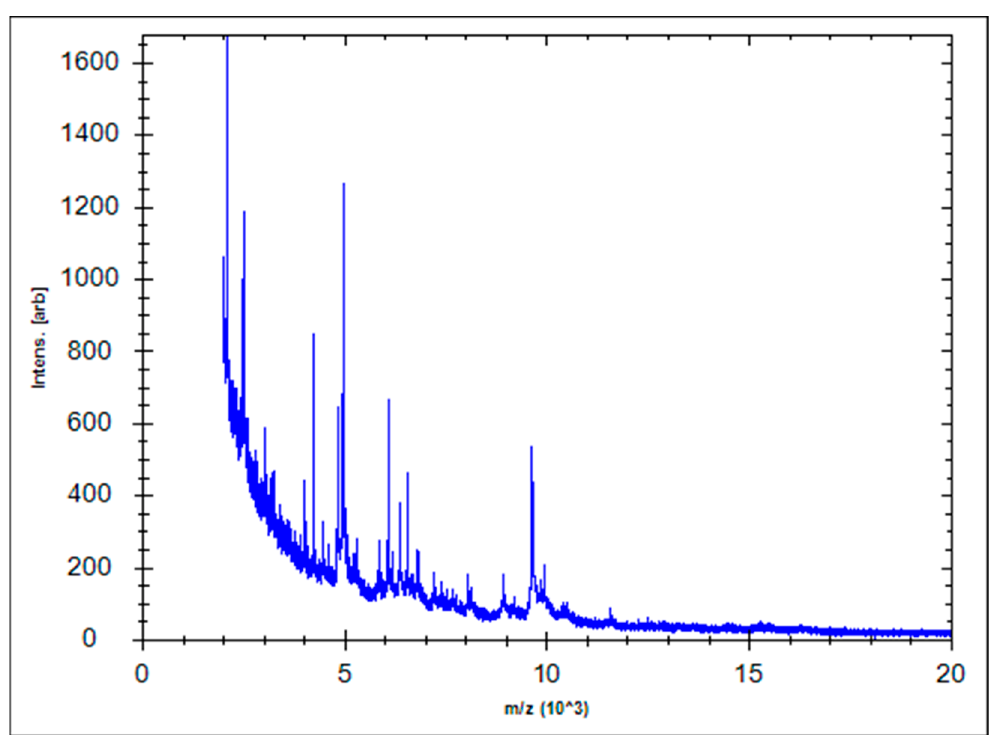
Figure 2. Spectra of S. xylosus generated using MALDI-TOF Bruker Biotyper. The y-axis represents the absolute intensity of the ions and x-axis represents the mass (m/z). The m/z value indicates the mass to charge ratio.